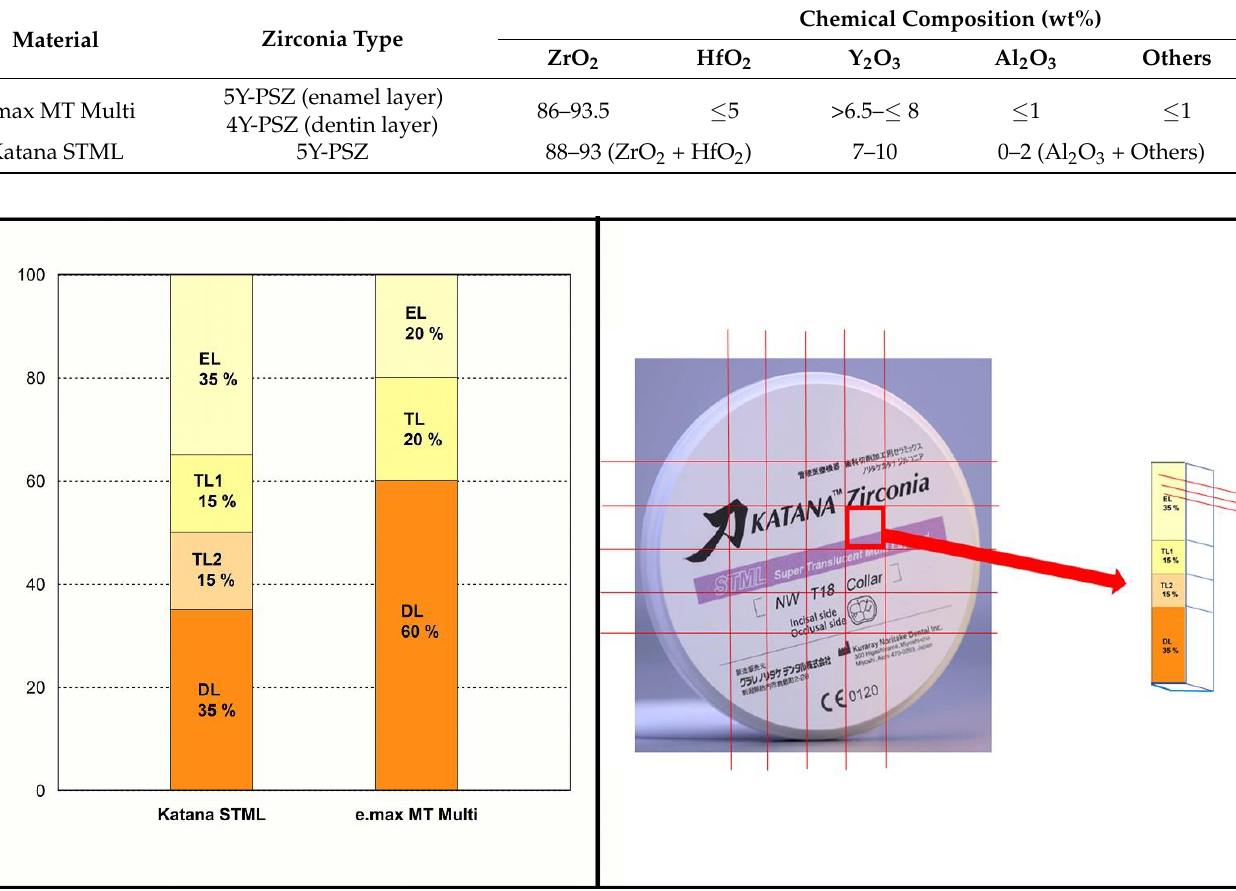
Figure 1. Left : layer fraction of used materials (EL: enamel layer; TL: transition layer; DL: dentin layer). Right : details of layer-by-layer cut for Katana STML (same method for e.max MT Multi). Table 2. Sintering protocols for the materials used.